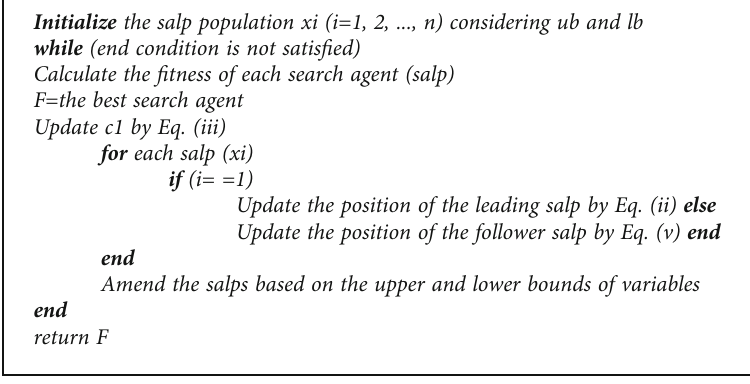
Algorithm 1: SSA Algorithm pseudocode.